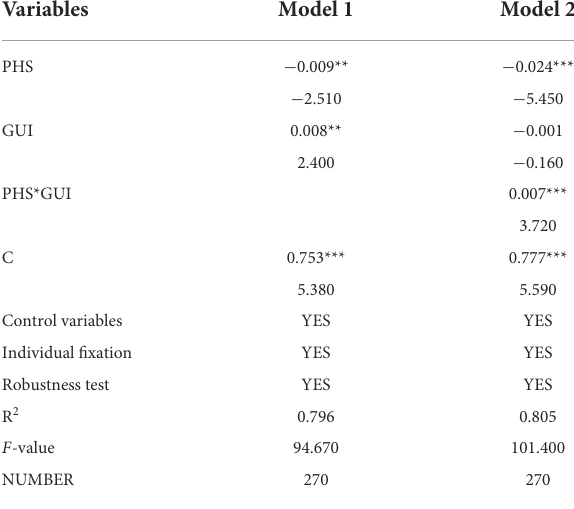
Heterogeneity analysis Geographic